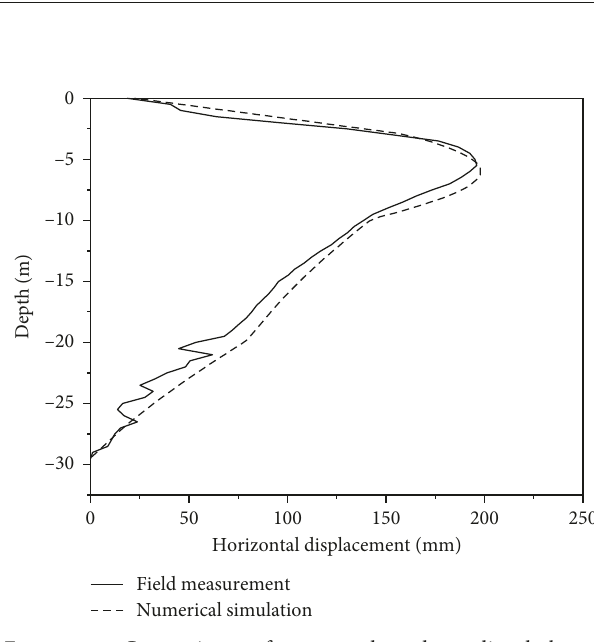
Figure 5: Comparison of measured and predicted lateral displacement.